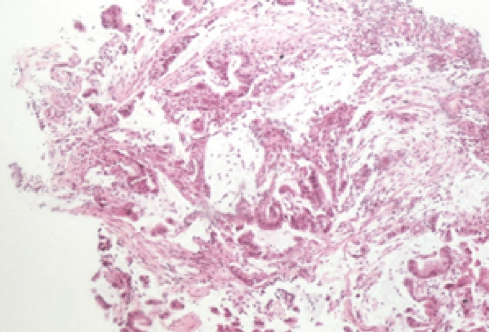
Figure 5: Invasive moderately differentiated mucinous adenocarci- noma.